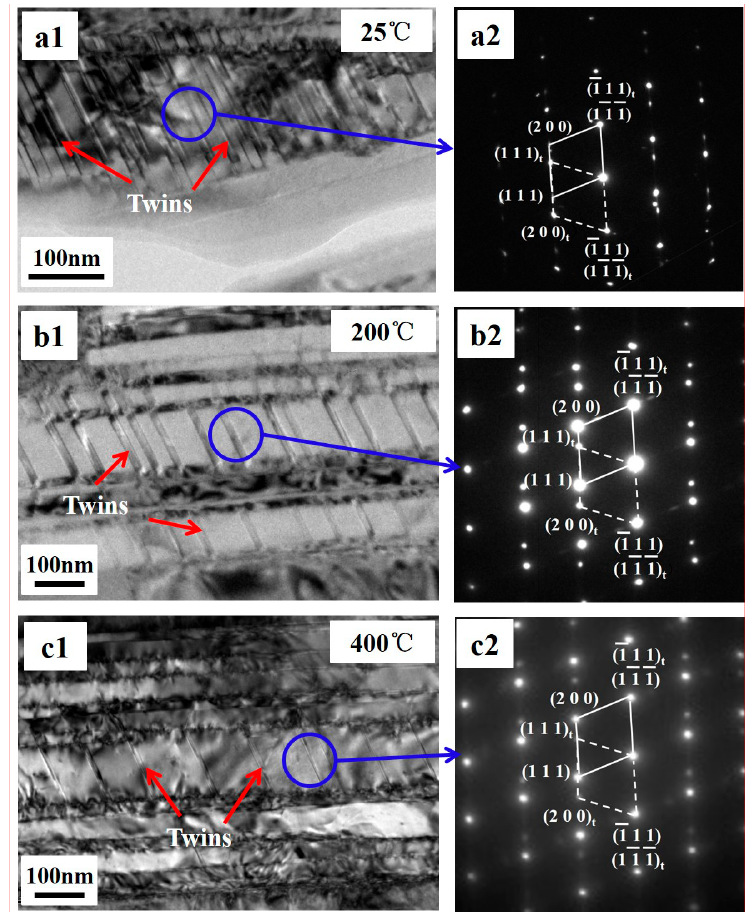
Figure 4. TEM micrographs and SAED of TNM alloy deformed at ( a1 , a2 ) 25 °C showing twins; ( b1 , b2 ) 200 °C showing twins; ( c1 , c2 ) 400 °C showing twins.